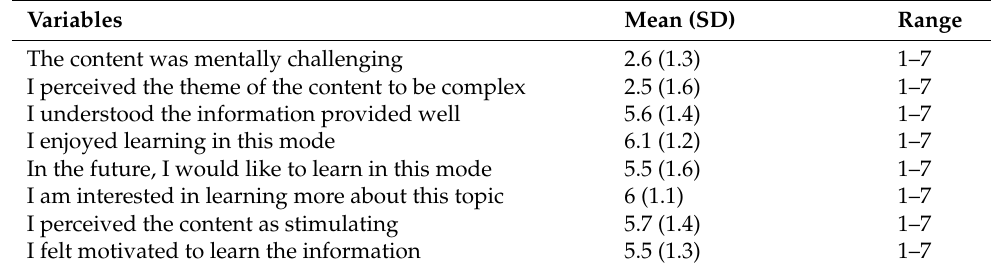
Table 4. The ad hoc questionnaire on learning using VR (N = 20).